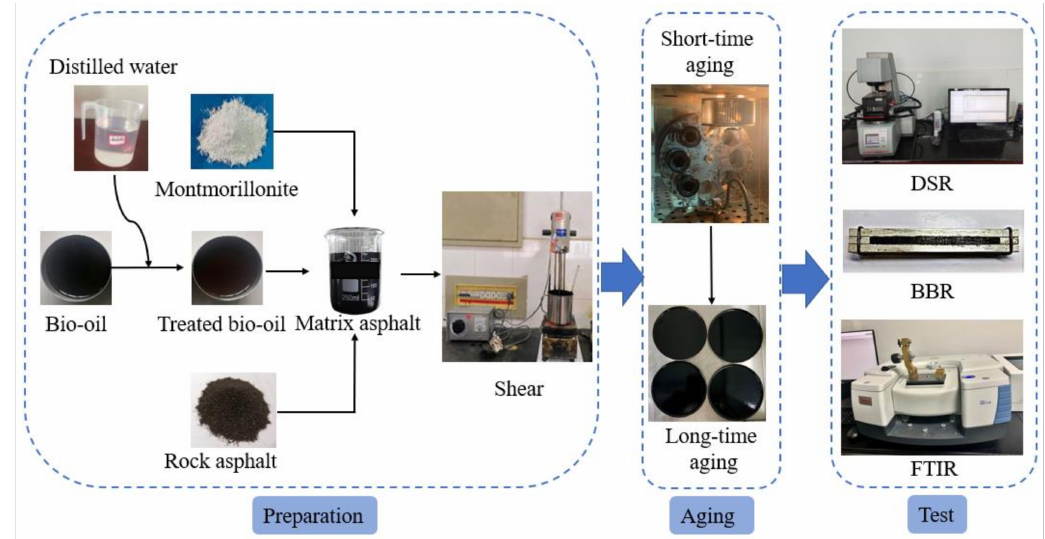
Figure 1. Test flow chart.